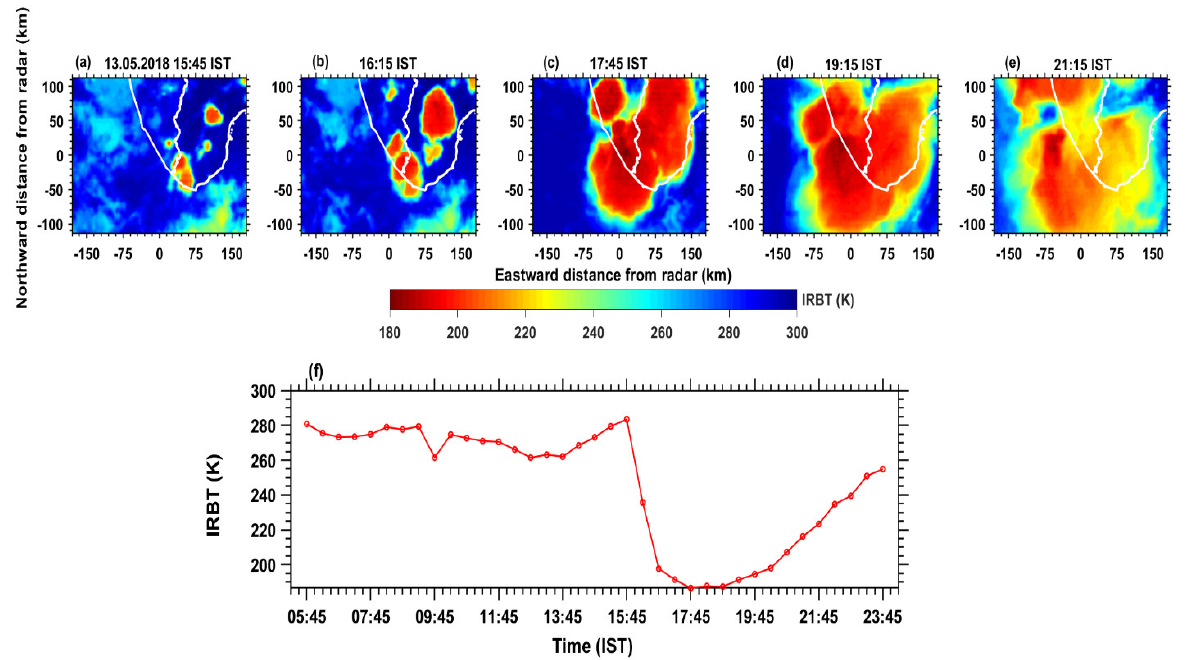
Figure 10. ( a – e ) Spatial–temporal evolution and ( f ) time series of infrared brightness temperature (K) over NCESS during the convective event on 13 May 2018 using INSAT-3DR satellite